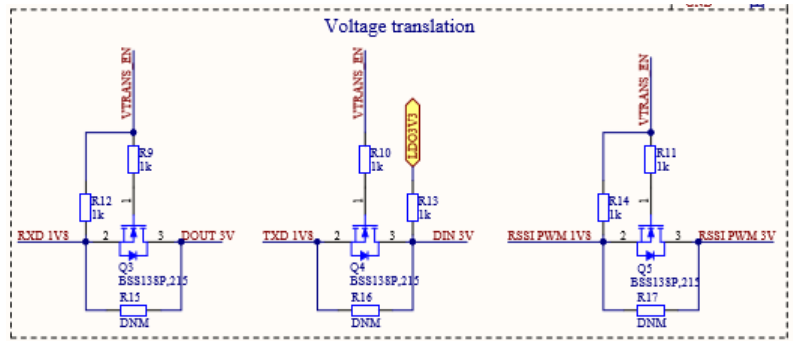
Figure 9. The1.8–3.3 V voltage level translation.